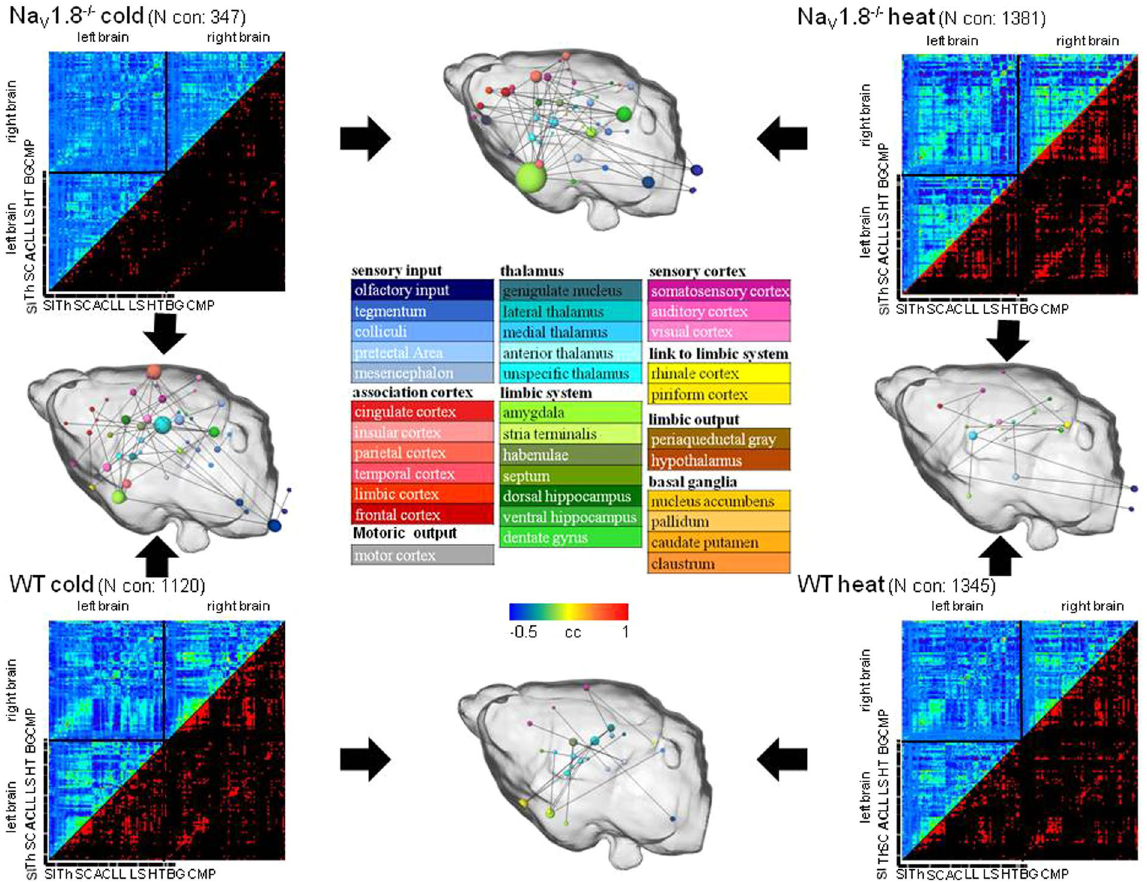
Figure 4. Changes in the interregional connectivity between pain-related brain structures in Na V 1.8 − / − in contrast to WT mice for cold and heat stimulation conditions. Average correlation maps of time-courses of the different brain structures are given in the upper triangle, the corresponding FDR thresholded binary matrices are given in the respective lower triangle. A colour scale indicates the degree of correlation (blue, green, and red indicate little, medium and strong correlation, respectively). Upon cold stimulation conditions the signal spreads from the thalamus to higher-order pain structures in WT mice (green areas), whereas obviously weaker activity is found in Na V 1.8 − / − mice (blue stripes). Correlation coefficients are given in the range from − 0.5 (blue) to + 1 (red). N = 10 for WT and Na V 1.8 − / − , respectively. Next, Student’s t-tests (two-sample; p ≤ 0.05, uncorrected) were calculated to reveal significant differences for the two genotypes and the two stimulation conditions and the result was transformed into 3D graphs consisting of nodes (brain structures, their 3D coordinates were derived from the Paxinos atlas 22 , color code see legend in the middle) and edges (connections, lines). The particular node size is given by the number of significantly different connections of a given Student’s t-test. Black arrows indicate the particular conditions which were tested. The graphs are rendered together with a transparent surface of the mouse brain. Abbreviations Fig. 4: SI, sensory input; Th, thalamus; SC, somatosensory cortex; AC, association cortex; LL, link to limbic system; LS, limbic system; HT, hypothalamus; BG, basal ganglia; C, cerebellum; M, motor cortex; P, periaqueductal